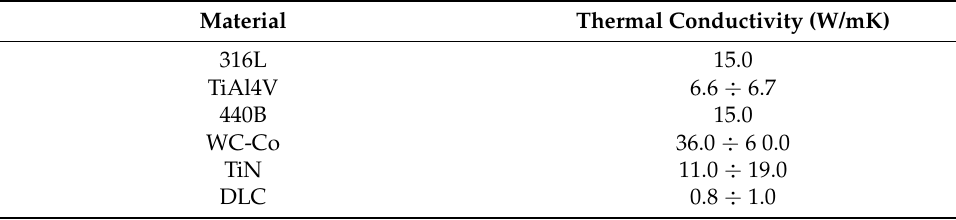
Table 6. Thermal conductivity of the materials subjected to friction tests [41–48].